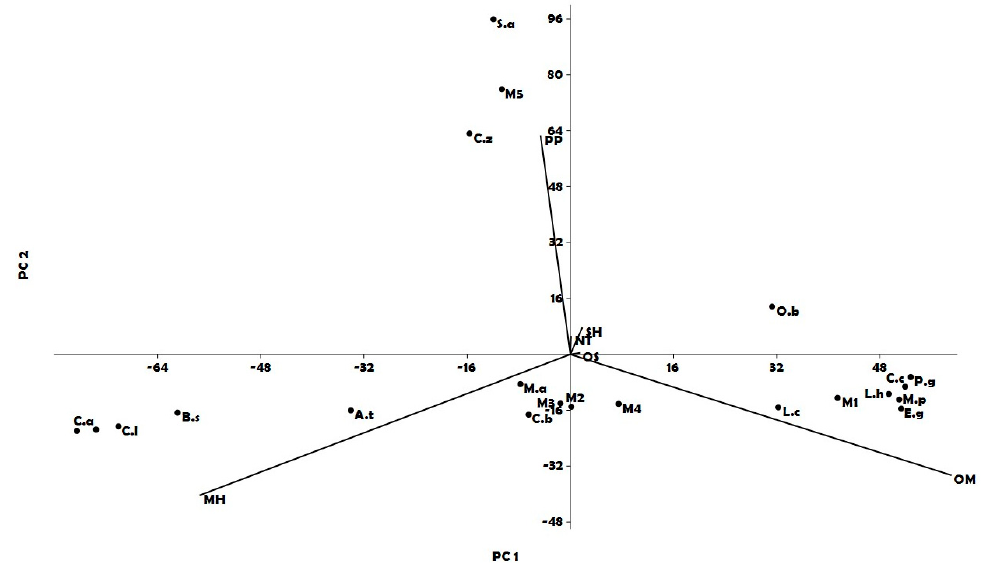
Figure 2. The compound analysis plot (PCA) of the main classes of compounds in the different